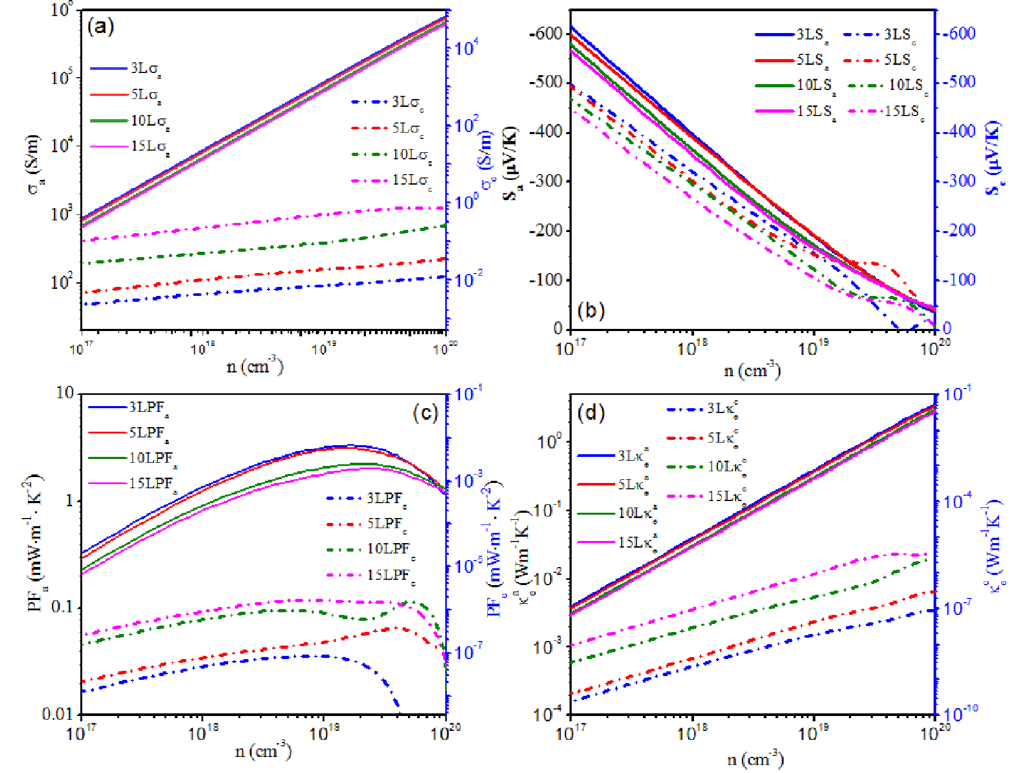
Figure 3. Calculated anisotropic electronic transport properties: electrical conductivity σ a and σ c ( a ), Seebeck coefficients S a and S c ( b ), power factor PF a and PF c ( c ) and electronic thermal conductivity κ ea and κ ec ( d ) as a function of carrier concentration for multilayer SnS 2 nanosheets with 3 L, 5 L, 10 L, 15 L. a and c refer to the transport properties of SnS 2 along the a-b plane and c direction,